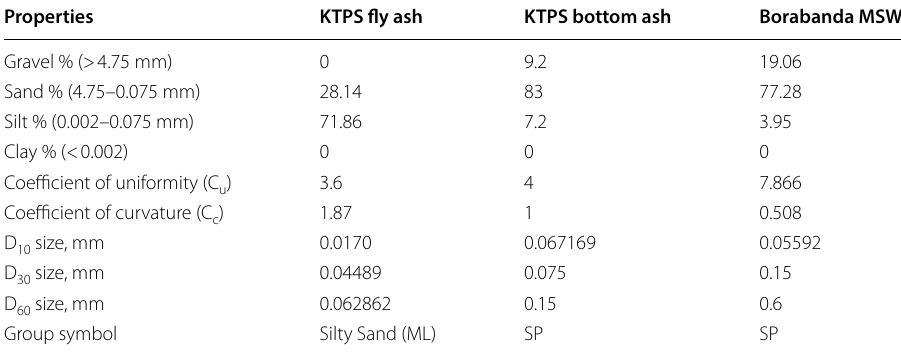
Table 1 Grain size characteristics of KTPS fly ash, KTPS bottom ash and Borabanda MSW Properties KTPS fly ash KTPS bottom